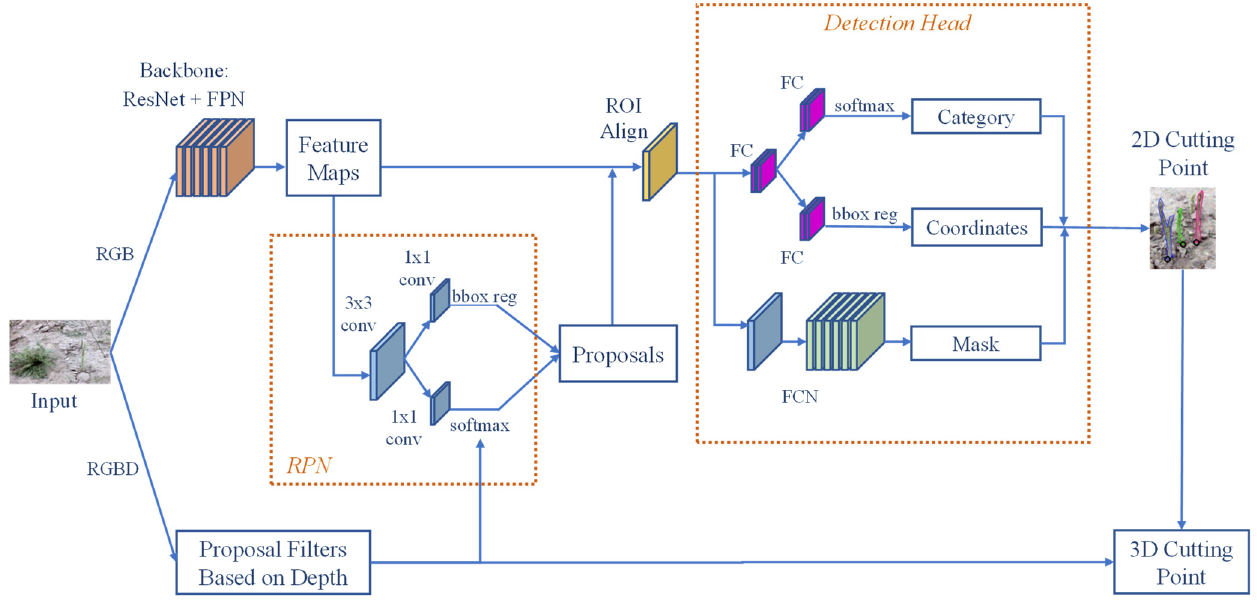
Figure 2. Structure of the DA ‐ Mask RCNN model.